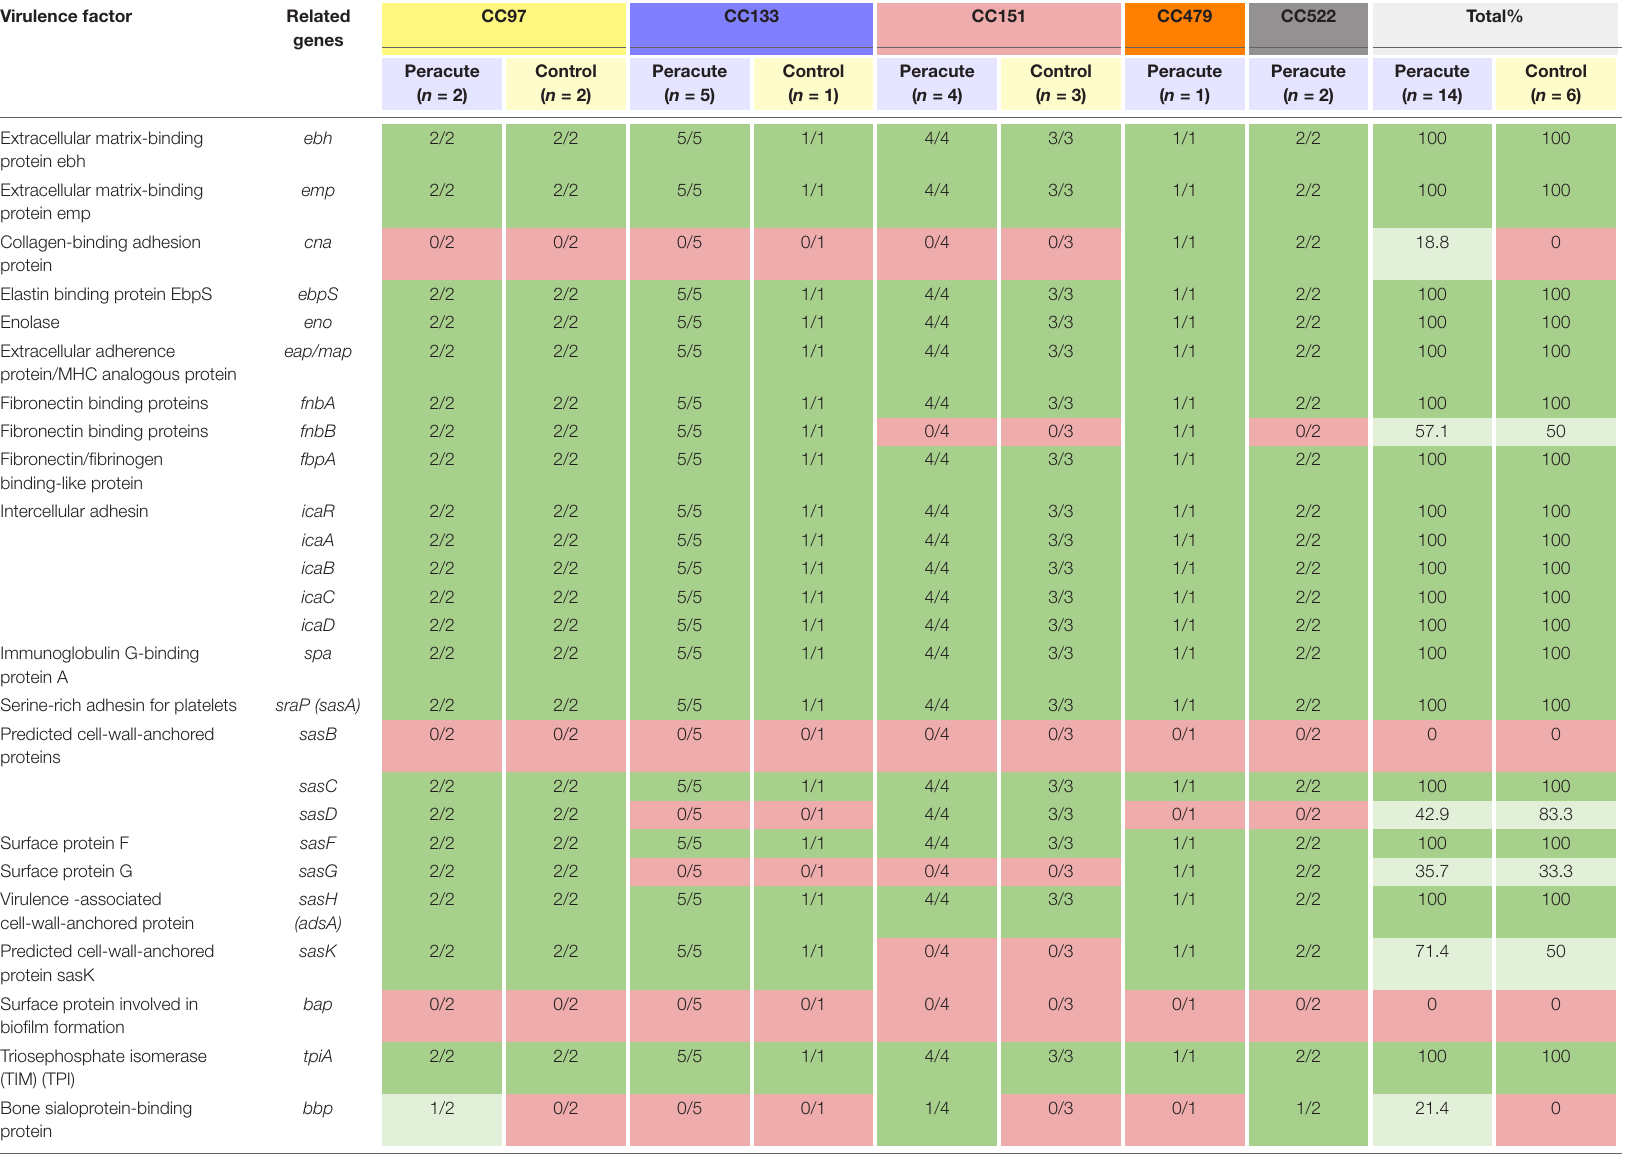
TABLE 8 | Distribution of adherence-related virulence genes in 20 Staphylococcus aureus isolates from bovine mastitis milk samples classified by clonal complex (CC) and study